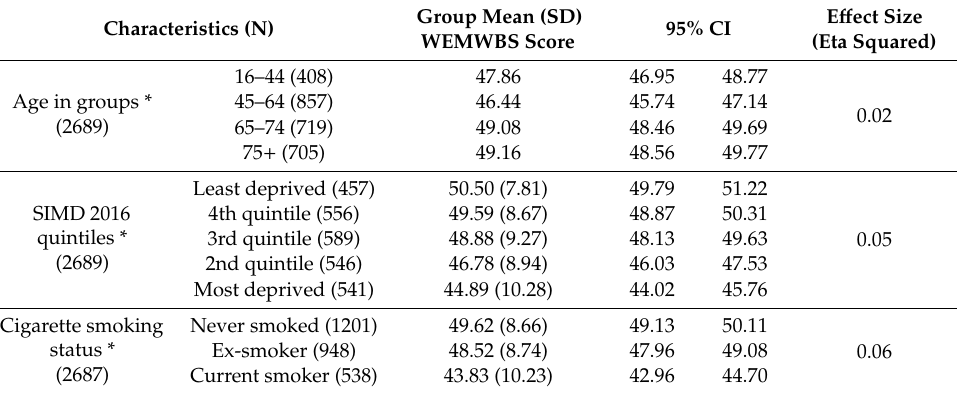
Table 3. Mean di ff erences of WEMWBS scores among selected categorical variable